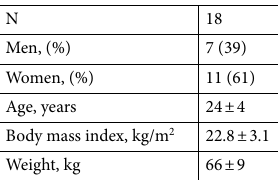
Table 1. Participant characteristics. Data are presented as mean ± standard